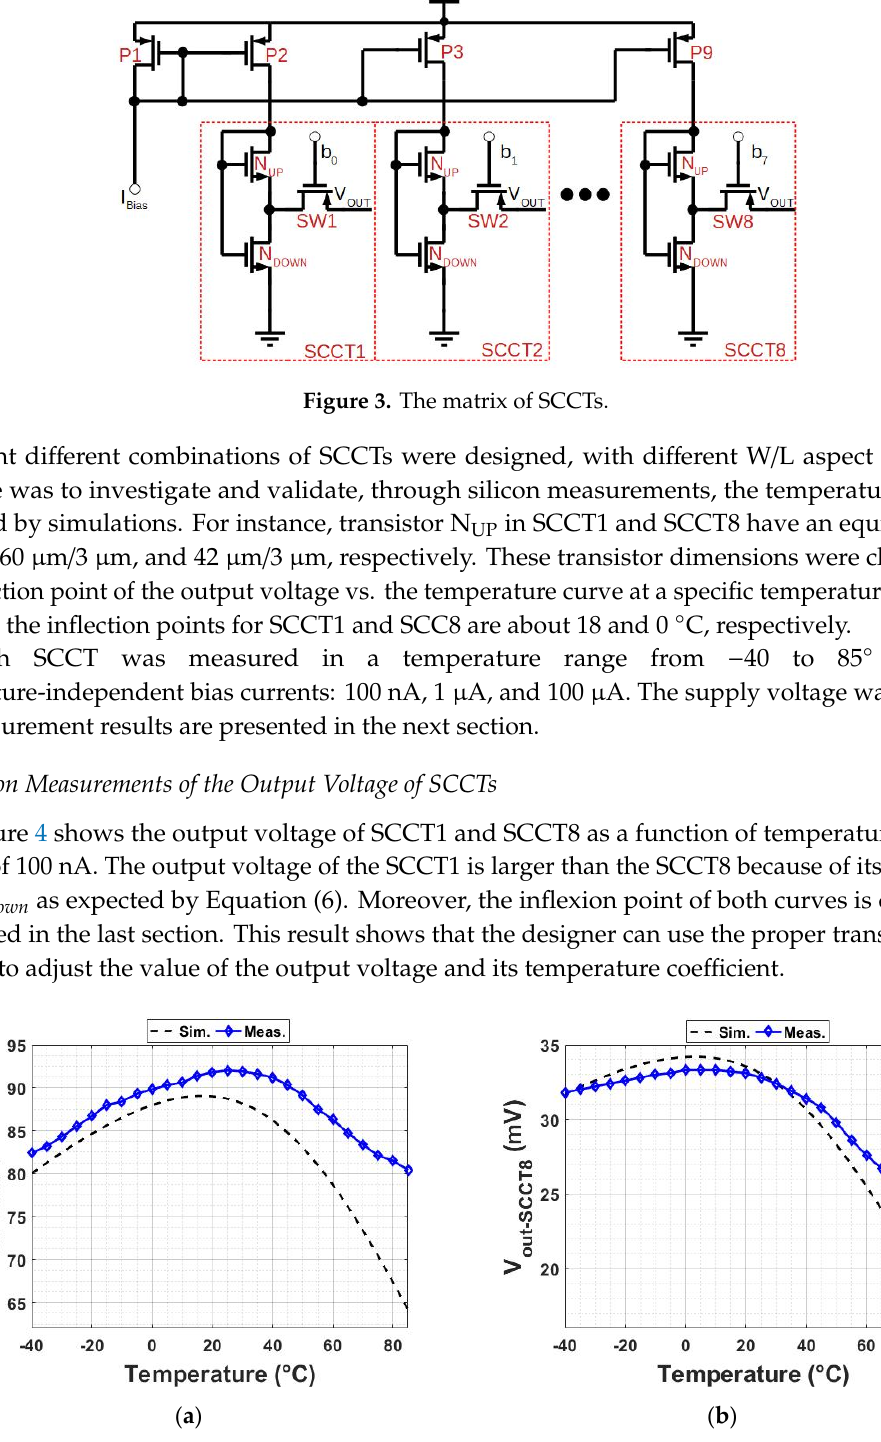
Figure 4. Measured output voltage as a function of temperature for the ( a ) SCCT1 and ( b ) SCCT8 using I Bias of 100 nA.